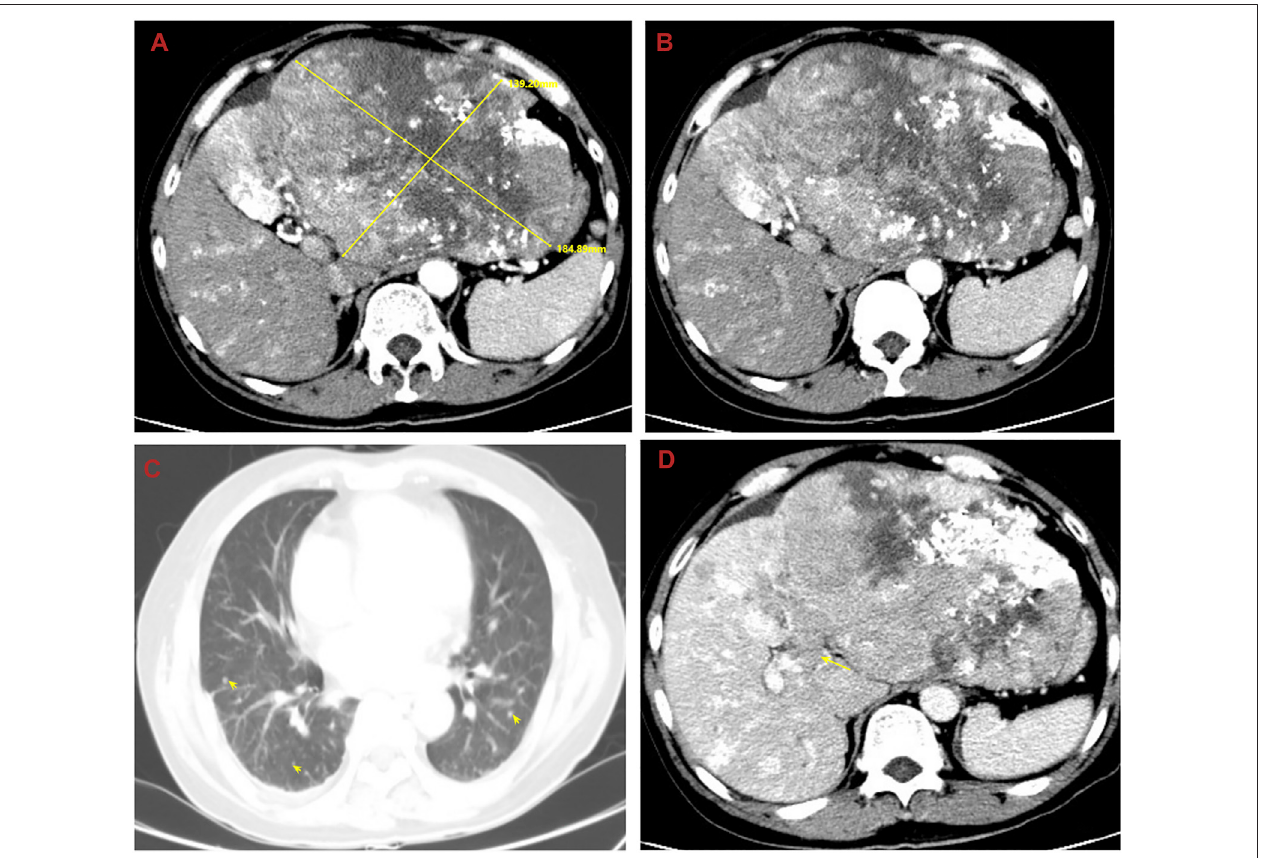
FIGURE 1 | Abdominal computed tomography (CT) shows the tumor in the left lobe of the liver considered to be HCC with multiple metastases in the right lobe of the liver, and withtumor thrombosis in theleft portalveinand lung metastases. (A) Thehuge tumor in theleft lobeoftheliver; (B) the multiplemetastasesin theright lobe of the liver; (C) the lung metastases; (D) the tumor thrombosis in the left portal